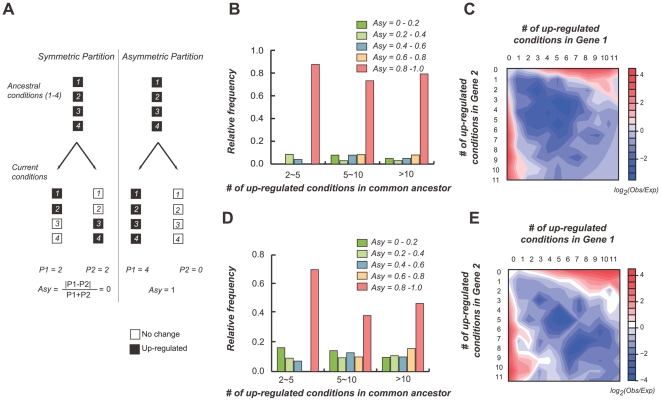
Extreme asymmetry in ancestral stress response partitioning among duplicates.(A) Asymmetry measure (Asy) definition. Asy was calculated based on the number of conditions, P, that each duplicate is responsive to. P1 is defined as the maximum number of responsive conditions among the two duplicates pairs. P2 is the minimum number. Extreme asymmetry was defined based on Asy = 1. (B) Relative frequencies of the number of duplicate pairs with various degrees of asymmetric partitioning. Here we only considered ancestrally up-regulated conditions. A similar plot for down-regulated conditions is shown in Figure S4. To demonstrate how Asy was affected by the number of conditions examined, the analyses were conducted using three datasets, each with a different number of informative conditions. (C) Over-representation of duplicate pairs with extremely asymmetric partitioning of stress responses with ancestral states taken into consideration. Log ratio (base 2) between the observed and expected number of duplicate pairs for each condition combinations was used as a measure of over- (red) and under-representation (blue) in the contour plot. The expected numbers were generated based on random binomial sampling. (D) Calculation of the relative frequencies of the number of duplicate pairs with various degrees of asymmetric partitioning without inferring ancestral states (up-regulation of extant genes is assumed to be ancestral). (E) Over-representation of duplicate pairs with extremely asymmetric partitioning of stress responses without considering ancestral states.